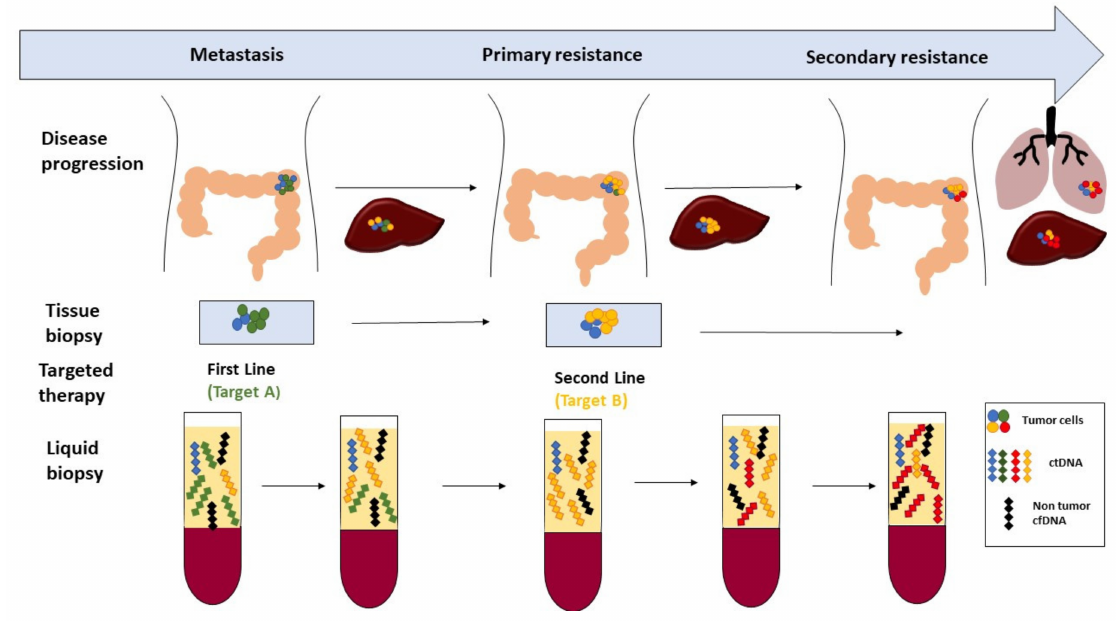
Figure 2. A liquid biopsy to monitor the therapy response and resistance. A hypothetical scenario of the developing chemotherapy resistance of colorectal cancer patients: first-line therapy is based on the primary tumor and relevant changes in the metastasis might be overlooked, therefore, leading to primary resistance. After switching to second-line therapy, secondary resistance may arise. Genetic changes of the resistant clones can be monitor using liquid biopsy and, therefore, the resistance mechanism might be recognized before disease progression (adapted from Heitzer et al.